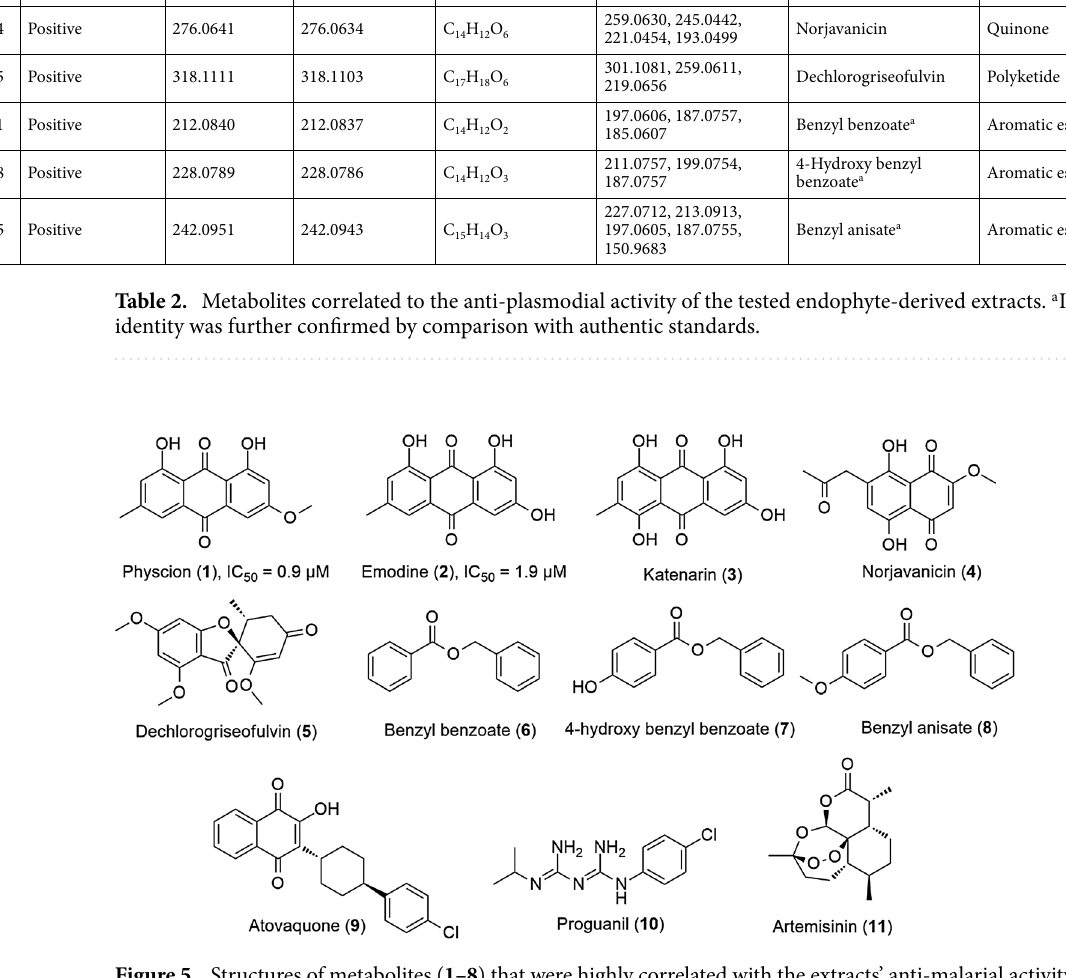
Figure 5. Structures of metabolites ( 1–8 ) that were highly correlated with the extracts’ anti-malarial activity alongside other well-known antimalarial agents ( 9–11